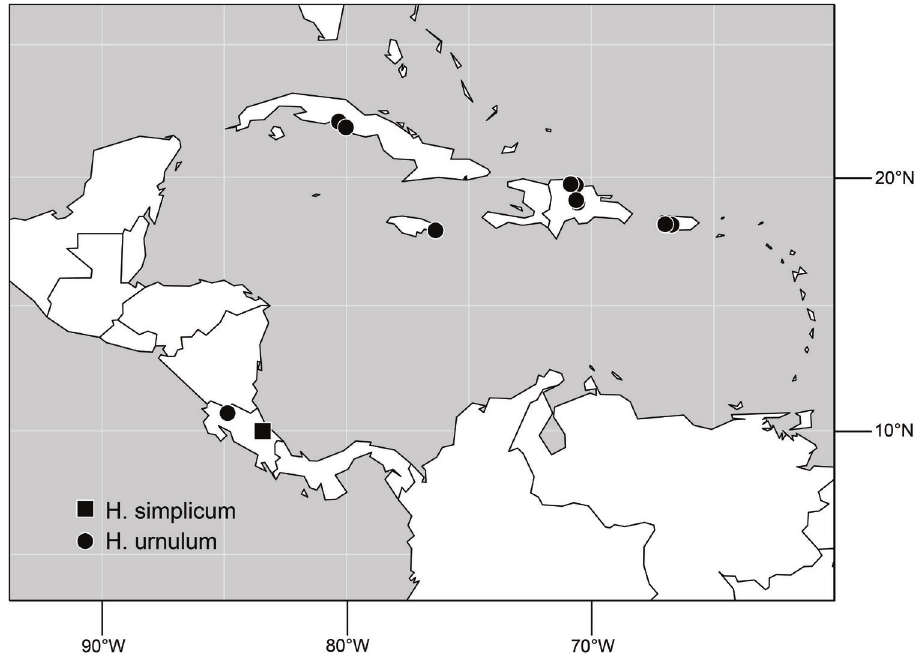
Figure 131. Distribution of Hydrochasma simplicum sp. n. and Hydrochasma urnulum sp.